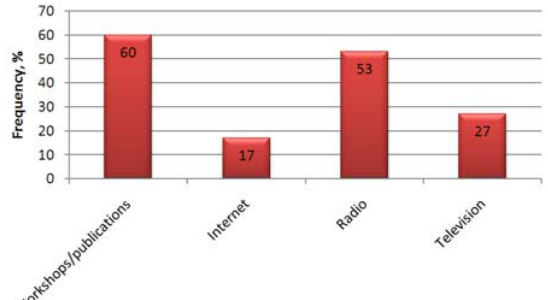
Fig. 10. Channels used by farmers to receive information updates